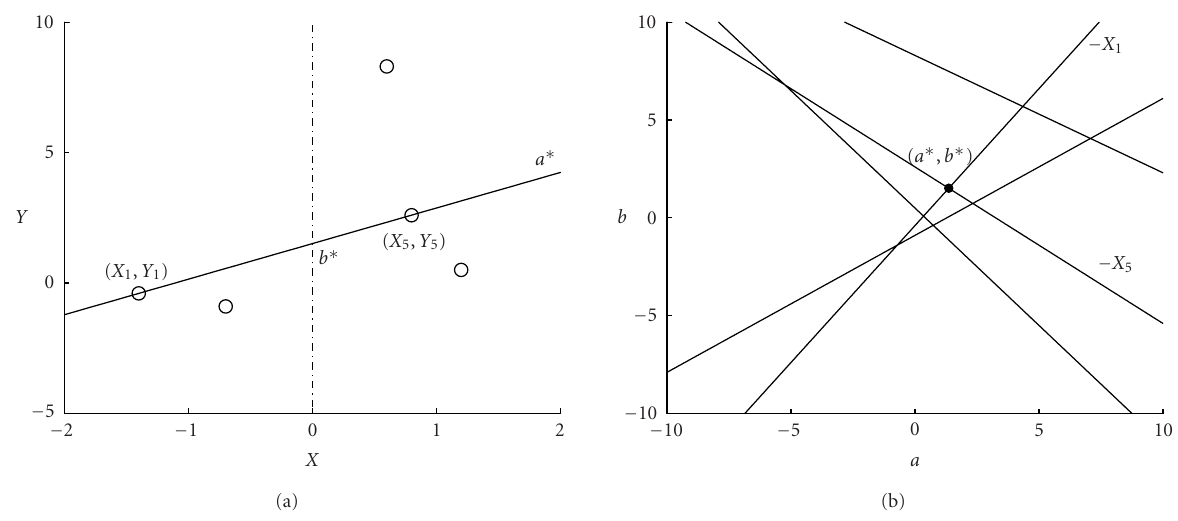
Figure 1: Illustration of (a) the sample space and (b) the parameter space in the simple linear regression problem. The circles in (a) represent the samples; the dot in (b) represents the global minimum.